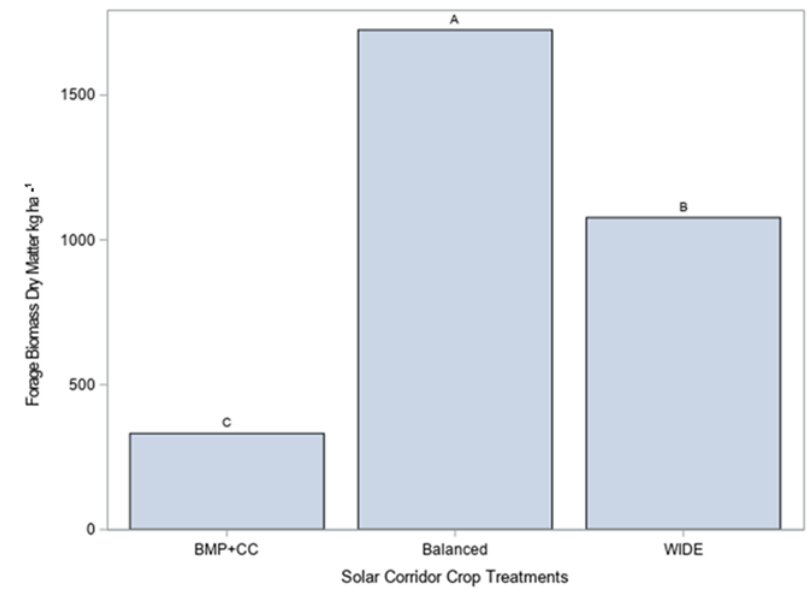
Figure 2. Row treatment and location effect on the relative forage biomass averaged across three locations in southeast MN, USA. BMP + CC, 76-cm rows with cover crop; Balanced, 76-cm with cover crops and two skip rows every fourth row; WIDE, 152-cm rows with a cover crop. All mean separation values were based on Fisher’s protected LSD at α = 0.05.